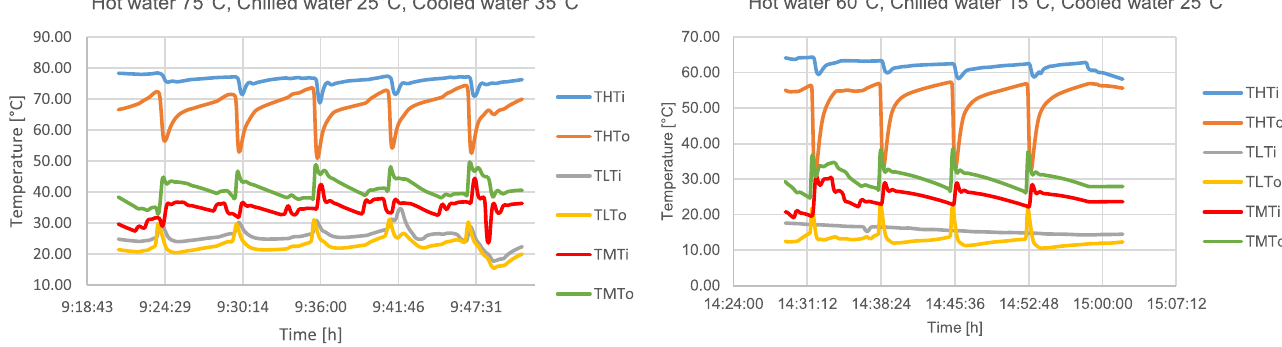
Fig. 8. Temperature variation at 60 ° C/15 ° C/25 ° C.